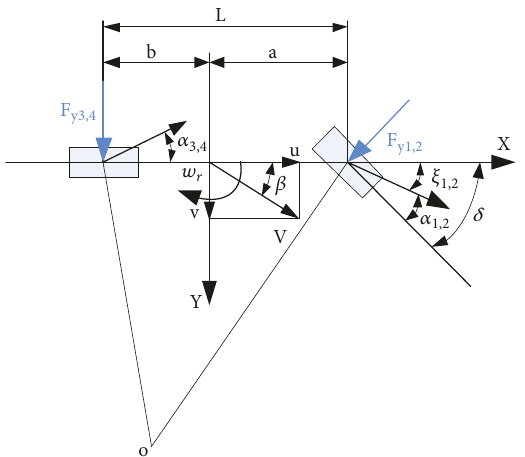
Figure 10: Vehicle motion and force analysis